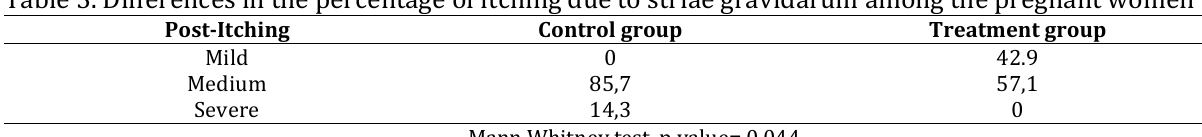
Table 3. Differences in the percentage of itching due to striae gravidarum among the pregnant